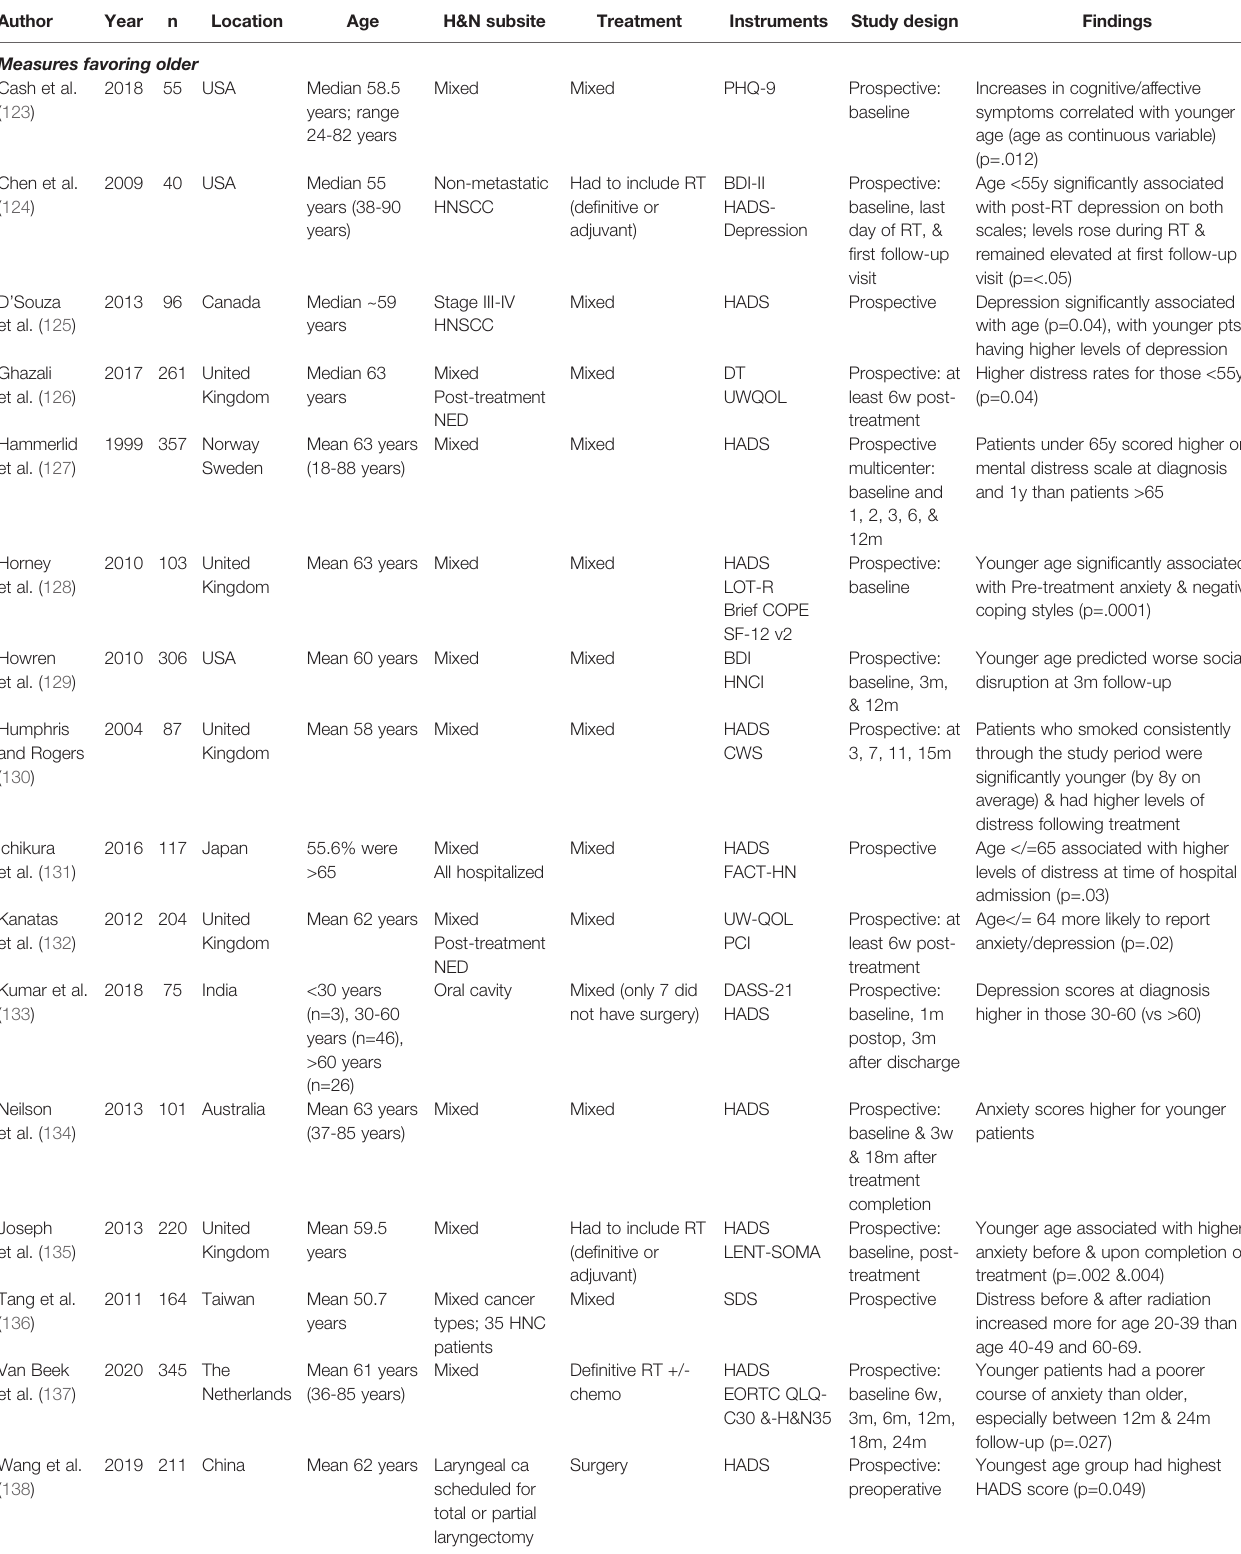
TABLE 8 | Prospective studies reporting distress and age in elderly patients with